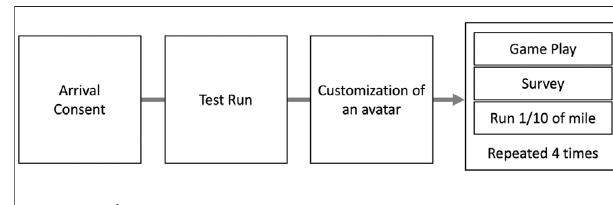
FIGURE 1 | Experimental procedure.